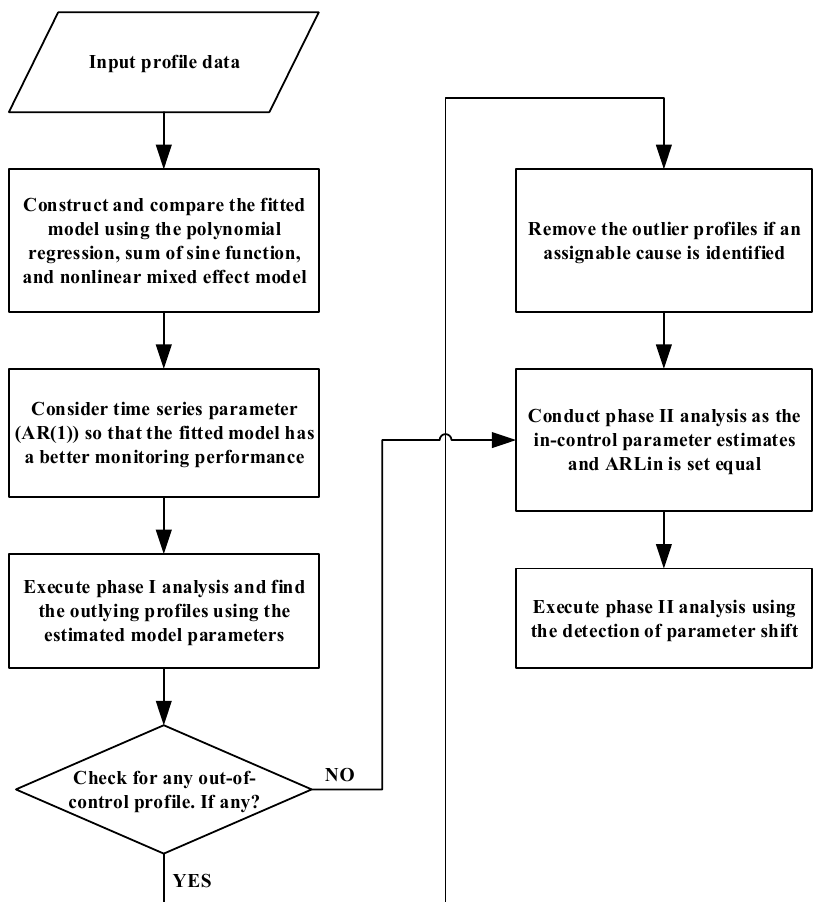
Figure 1. Flow chart for the proposed framework.